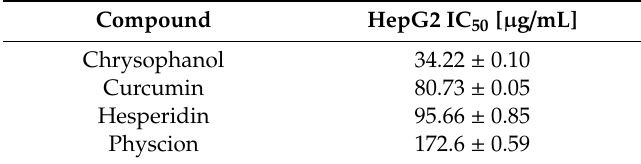
Table 2. IC 50 of the isolated compounds at di ff erent concentrations (100, 50, 25, 12.5, and 3.25 µ g / mL) on HepG2.